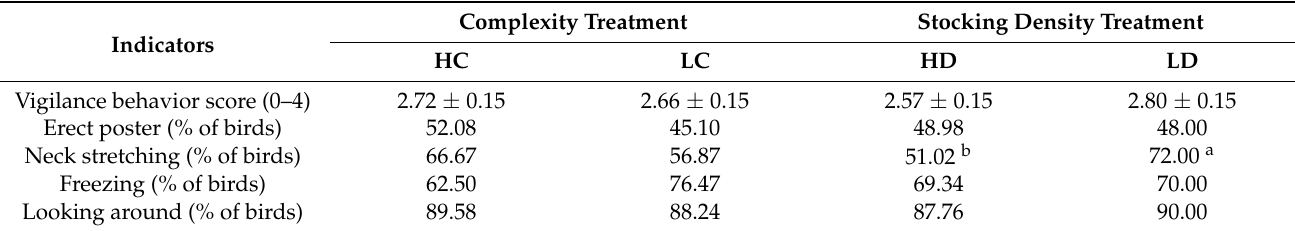
Figure 4. Least squares mean estimates (s ± SEM) for latency to begin feeding ( n = 144) and resume feeding ( n = 78) for broiler chickens kept in high-complexity, low-complexity, high-density, and low-density treatments in Experiment 2 at 4 and 5 weeks of age (days 32, 33, and 38). The timer was reset to zero after the second alarm call was played to record latency to resume feeding. * p < 0.05. Table 7. Least squares mean estimates ( ± SEM) for vigilance behavior scores and % of each type of vigilance behavior observed for broiler chickens kept in high-complexity (HC), low-complexity (LC), high-density (HD), and low-density (LD) treatments ( n = 99) in Experiment 2 at 4 and 5 weeks of age (days 32, 33, and 38). Birds were scored either 0 (not observed) or 1 (observed) for each of four vigilance behavior characteristics (erect posture, neck stretching, freezing, and looking around), giving a vigilance score between 0 (no vigilance behavior observed) and 4 (all vigilance behaviors ob- served).